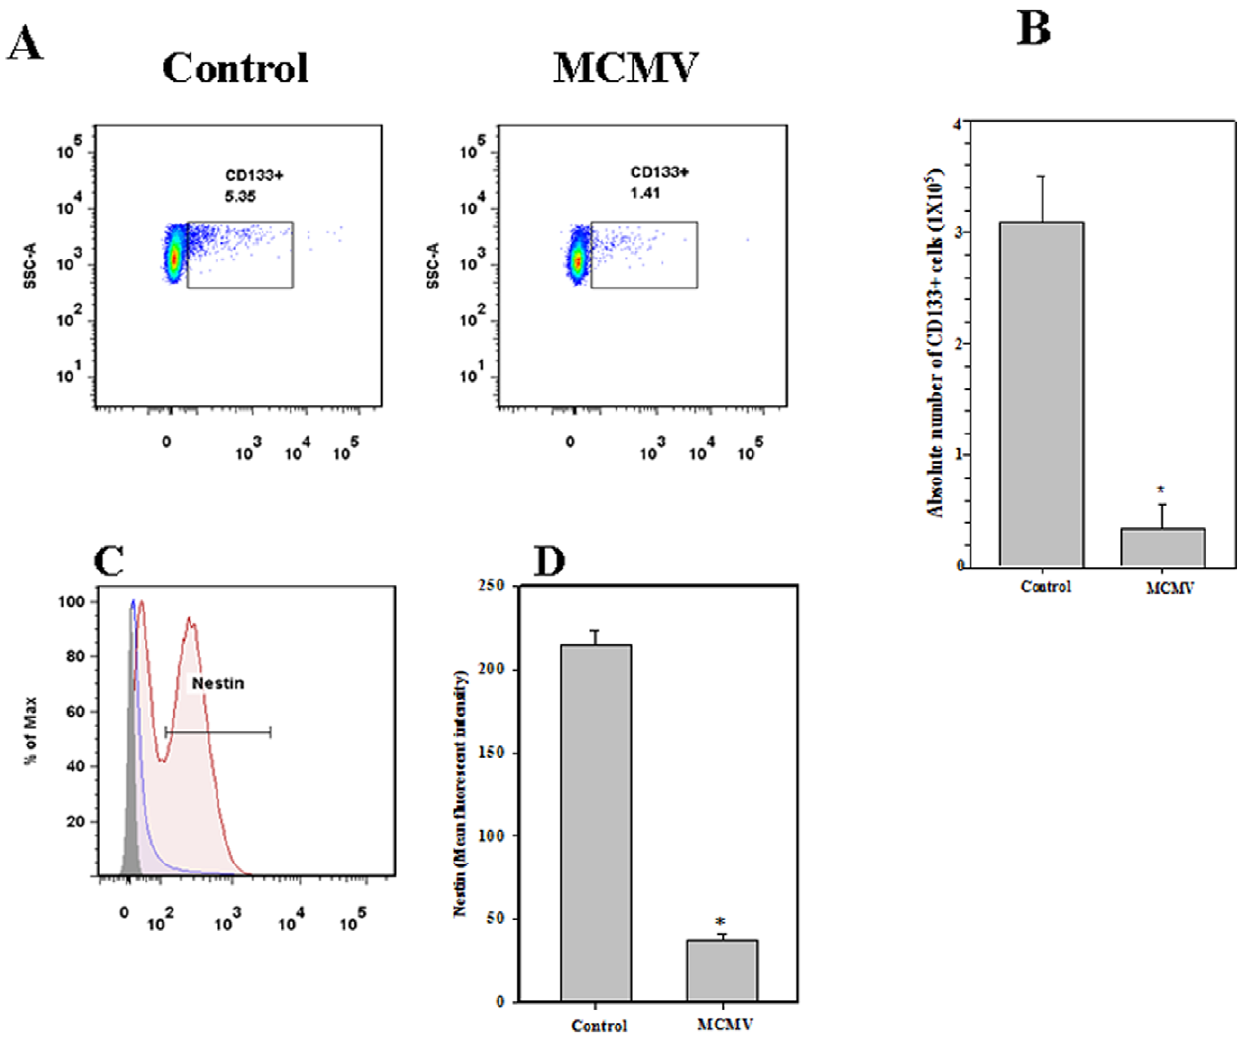
Figure 3. Viral infection reduces the number of CD133( + ) cells and alters nestin expression in the developing brain. A . Representative dotplots from mock-infected and MCMV-infected brains showing CD133( + ) cells at 7 d p.i. Dissociated brain-derived cells were incubated with CD133( + ) Mabs and analyzed by flow cytometry. Live cell gating was performed by using 7 AAD, the live cells were also excluded from immune cells that may infiltrate during the infection using CD45-PE-Cy5. B . The absolute numbers of CD133( + ) cells obtained from infected brains versus control brains are shown. Data were derived from 3 independent experiments, n=3–5 neonates. * p , 0.05 versus mock infected. The cells prepared from P7 brain were also stained for intracellular nestin expression. C . Representative histogram overlays from isotype (grey line, filled) uninfected (red line, tinge) and infected (blue line) brains. D . Mean fluorescent intensity for nestin expression was calculated and found to be significantly lower in the cells isolated from virus-infected brain. Data were derived from 3 independent experiments, n=3–5 neonates. * p , 0.05 versus control new born